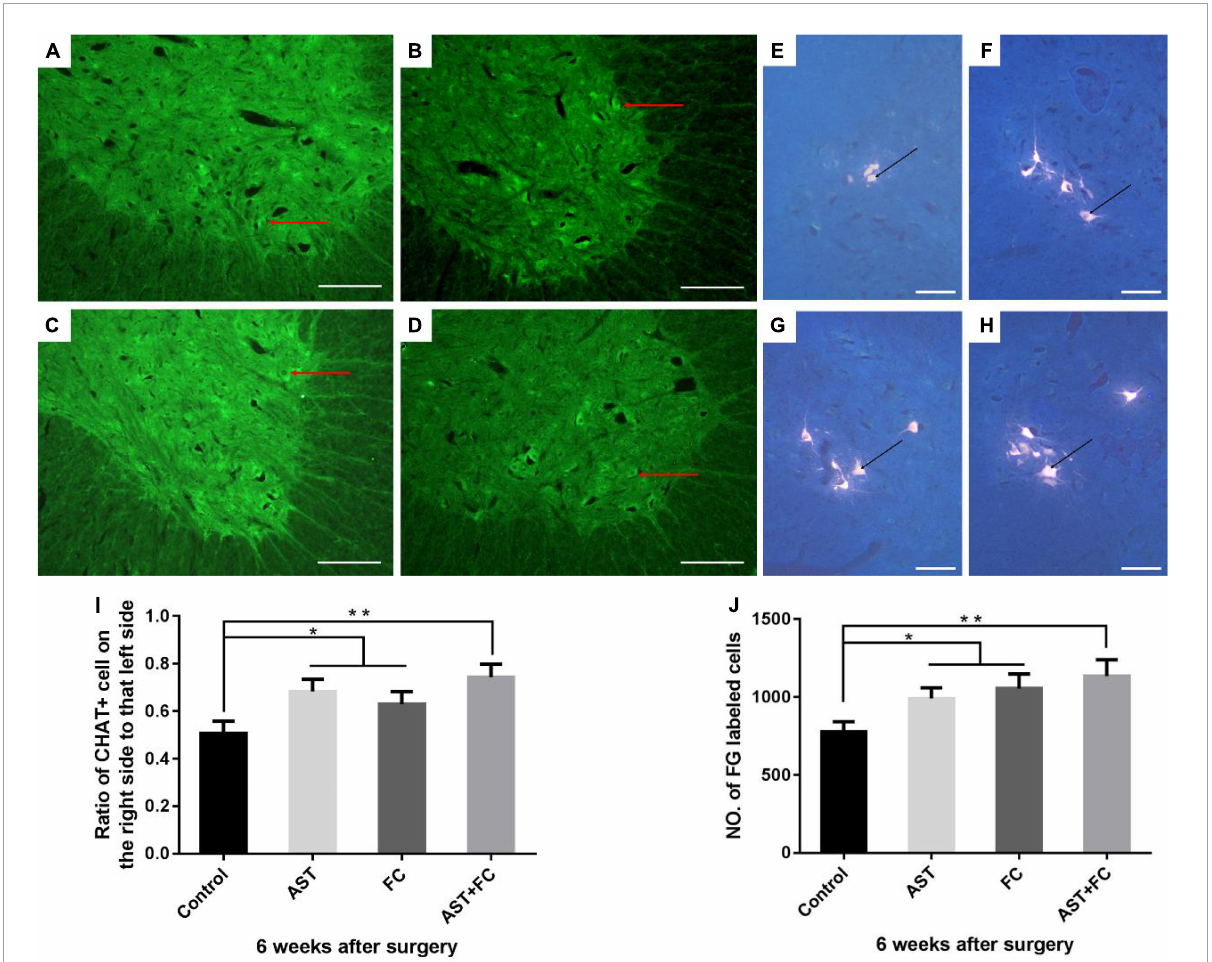
FIGURE4 Quantification of viable ventral motor neuron counts and survival rates, and the number of FG-labeled ventral horn motor neurons on the injured side in control, AST, FC, and AST + FC groups at 6 weeks after BPA. (A–D) The number and morphology of ventral horn motor neurons on the injured side at 6 weeks after BPA and represent the control, AST, FC, and AST + FC groups, respectively (bar = 100 um); (E–H) C5–C8 FG-labeled ventral horn motor neurons in control, AST, FC, and AST + FC groups at 6 weeks after BPA and represent the control, AST, FC, and AST + FC groups, respectively (the black dots indicate ventral horn motor neurons, bar = 50 µ m). (I) Ratios between the percentage of viable ventral horn motor neurons on the injured side and that on the healthy side ( n = 3, * p < 0.05, ** p < 0.01). (J) Statistical comparison of the number of FG-labeled motor neurons in each group ( n = 3, * p < 0.05, ** p <